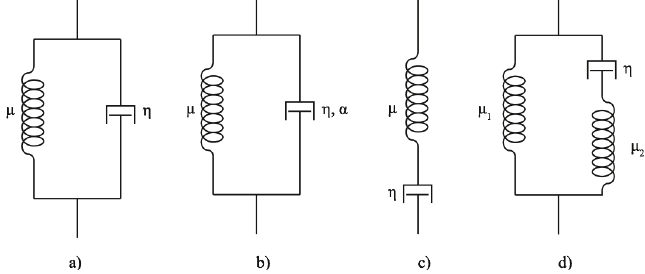
Figure 5. Rheological models. ( a ) the Kelvin–Voigt model; ( b ) the Kelvin–Voigt Fractional Derivative model; ( c ) the Maxwell model; ( d ) the Zener